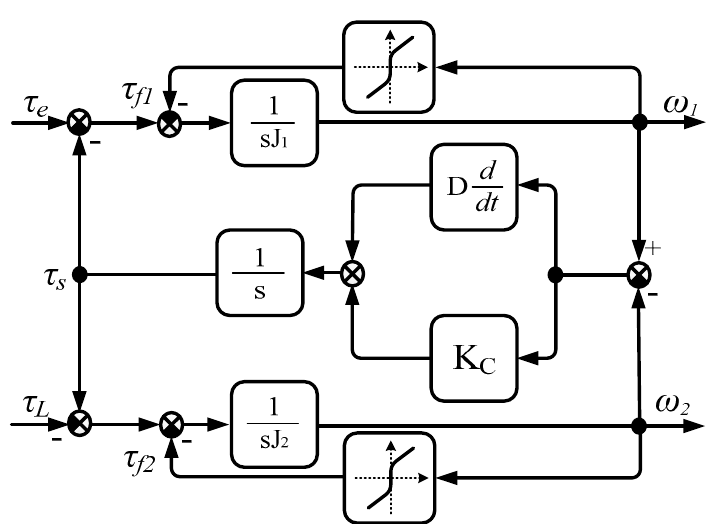
Figure 5. Block diagram of mechanical part of driver system with elastic coupling and friction.